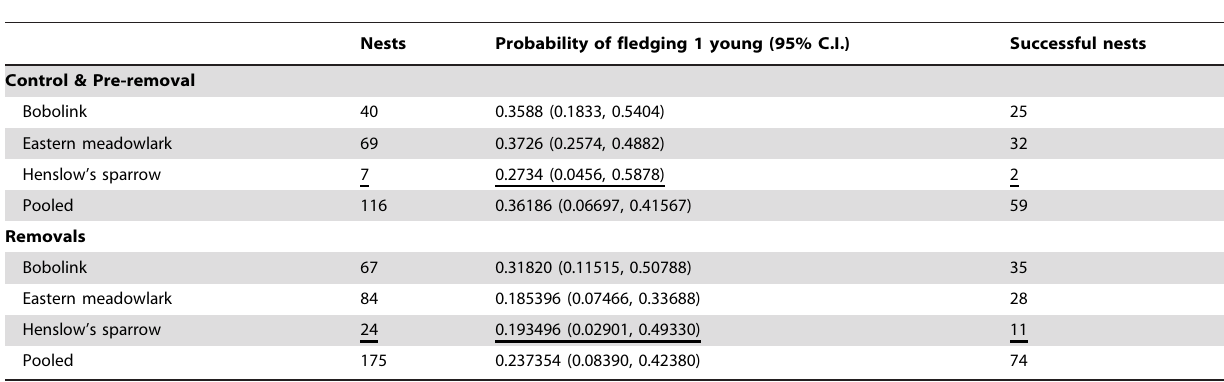
Table 3. The probabilities (Daily Survival Rates) for nests fledging $ 1 young, listed by species pooled at the whole field level by